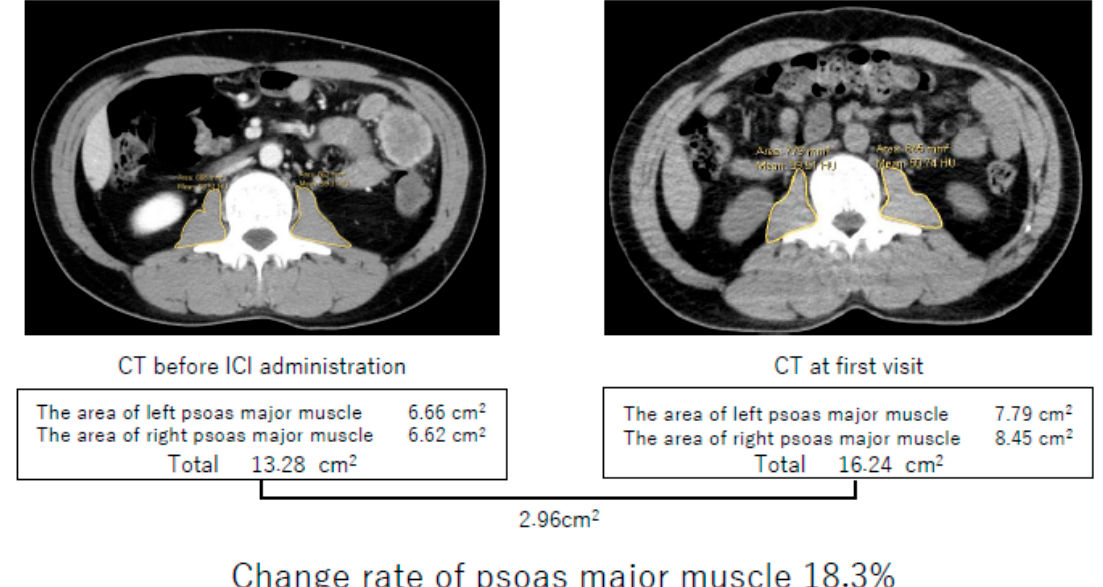
Figure 1. Method of calculating change rate of the psoas major muscle area (PMMA). PMMA was calculated as the sum of both the right and left area of the psoas major muscle at the L2–L3 position. In this case, PMMA before immune checkpoint inhibitor administration was 13.28 cm 2 , and PMMA at first visit was 16.24 cm 2 . Using these data, we could calculate the change rate of PMMA: Change rate of PMMA (%) = (1 − 13.28 / 16.24) × 100 =